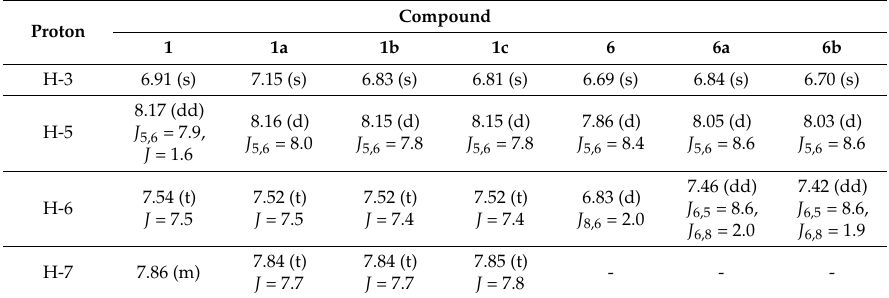
1 H-NMR shifts ( δ ) of flavone ( 1 ) and 7-aminoflavone ( 6 ) and products of their biotransformations ( 1a , 1b , 1c , 6a , 6b ) in Acetone- d 6 , 600 MHz (Supplementary